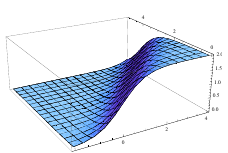
Fig. 1 Kink solution with λ =